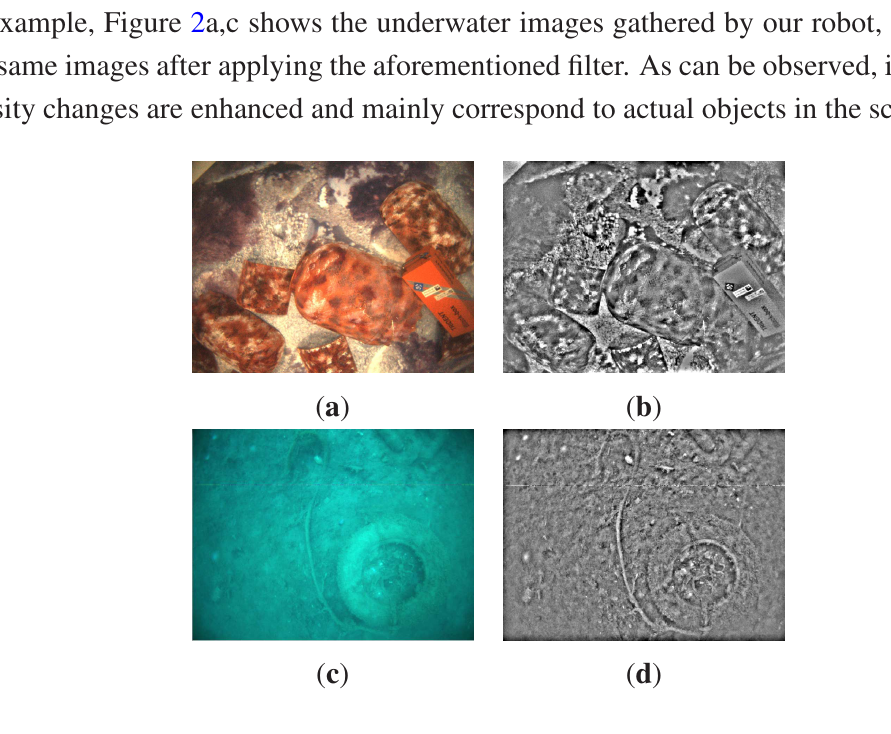
Figure 2. Image processing prior to the image registration. ( a , c ) Original images; ( b , d ) filtered